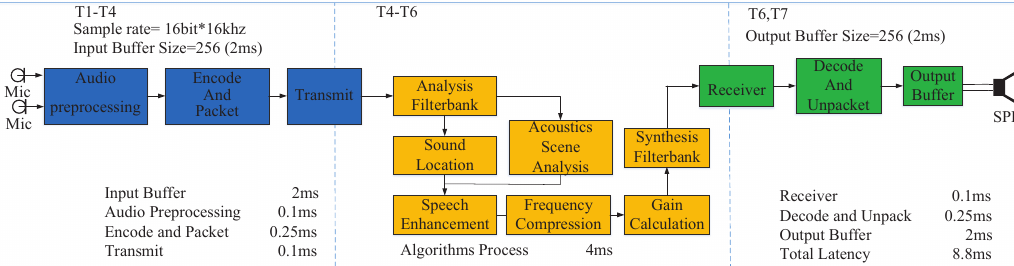
Figure 15. Block diagram with system delay